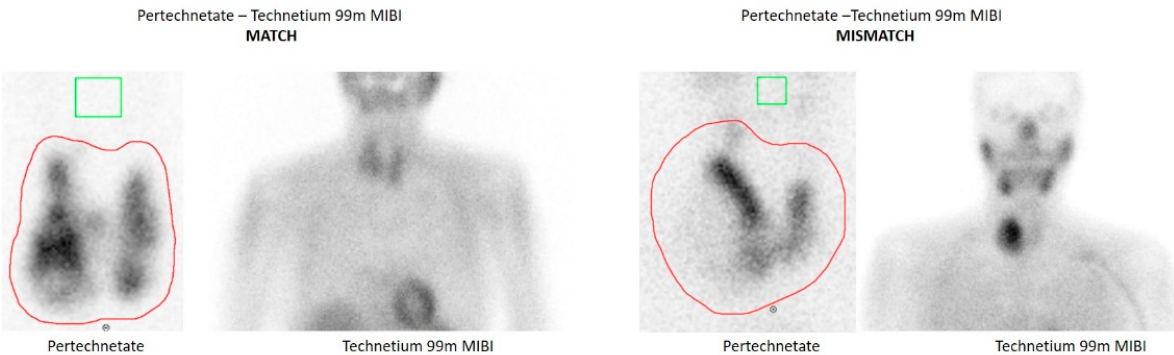
Figure 1. Examples of match and mismatch between pertechnetate and Tc-99m-MIBI scintigraphy. Tc-99m-MIBI images are correlated to Tc-99m-pertechnetate scintigraphy and classified as a “match” (no uptake compared to normal thyroid tissue), as an intermediate finding (isointense uptake to normal thyroid tissue), or a “mismatch” (significant uptake compared to normal thyroid tissue and in contrast to the lacking uptake in pertechnetate scintigraphy).